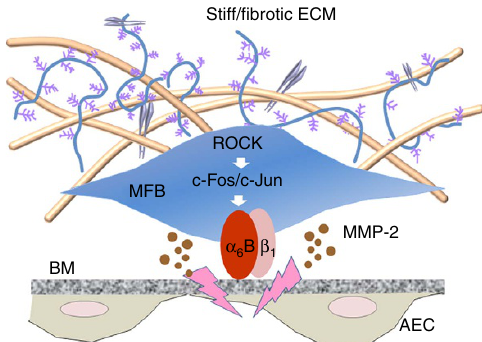
Figure 6 | A model for mechanosensing a 6 in the regulation of lung myofibroblast invasion into the BM. Stiff/fibrotic matrix upregulates a 6 -expression by ROCK-dependent activation of c-Fos/c-Jun transcription complex. Interactions between a 6 -integrins, specifically a 6 B b 1 -integrins, and the BM bring lung myofibroblasts into the close proximity to the BM. This facilitates MMP-2-mediated pericellular proteolysis of BM component collagen IV, leading to lung myofibroblast